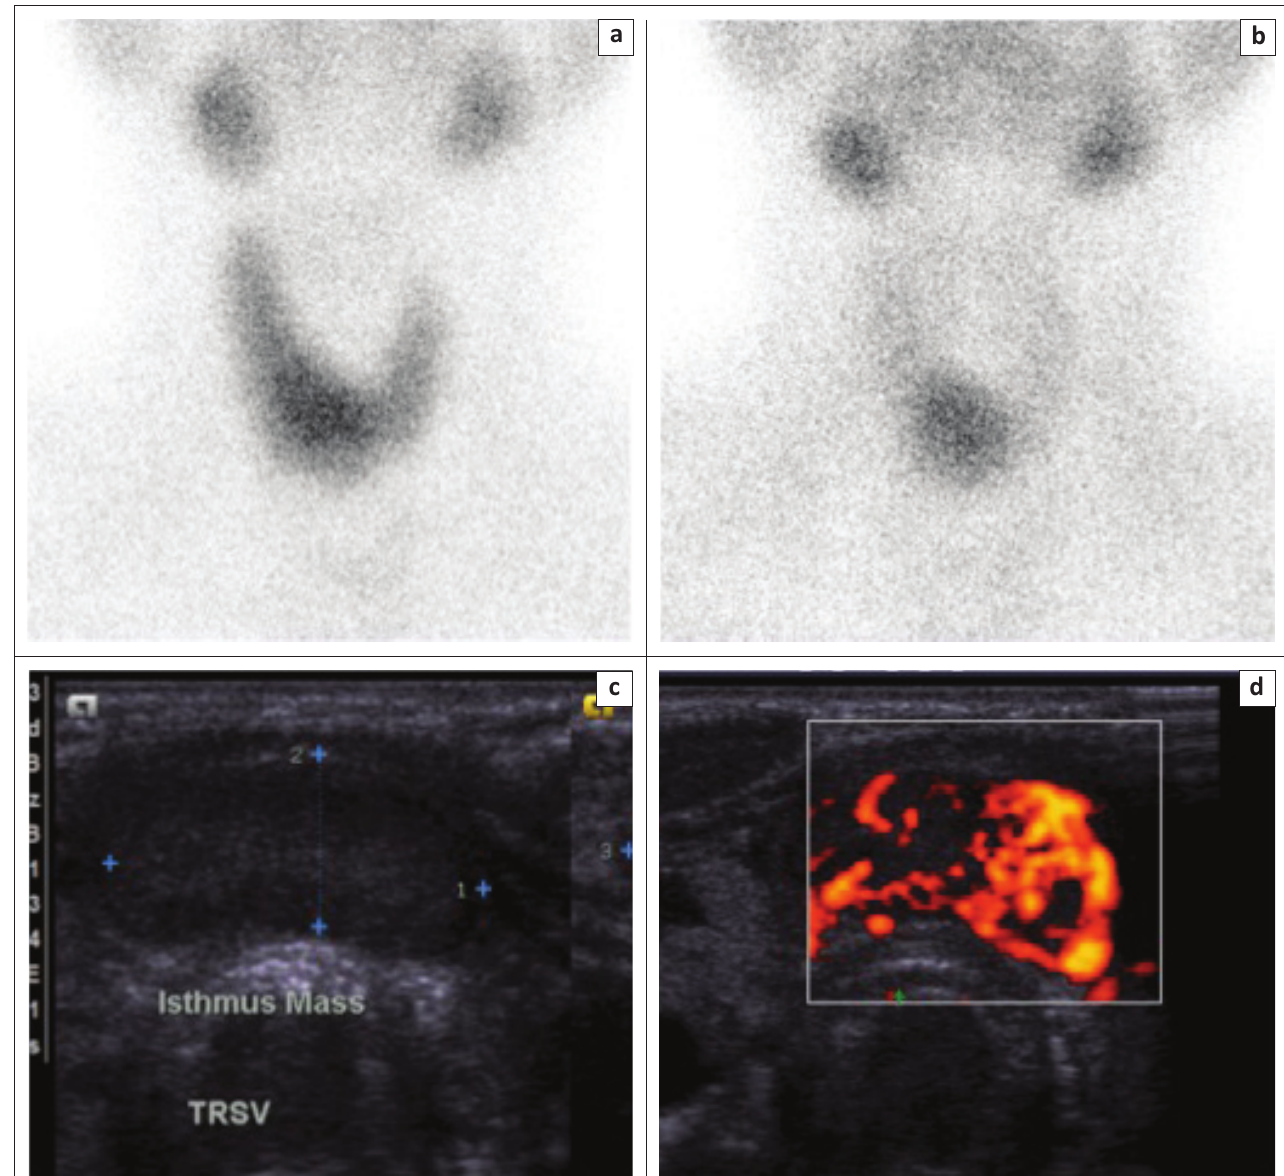
FIGURE 1: 99mTc-MIBI scintigraphy and ultrasonography of the thyroid of a 36-year-old woman with isthmic thyroid nodule. There is increased activity on early (a) and delayed (b) 99mTc-MIBI scan. Ultrasonography showed a well-defined nodule (c) with marked intranodular vascularity pattern on power Doppler (d). Histology confirmed an Hürthle cell